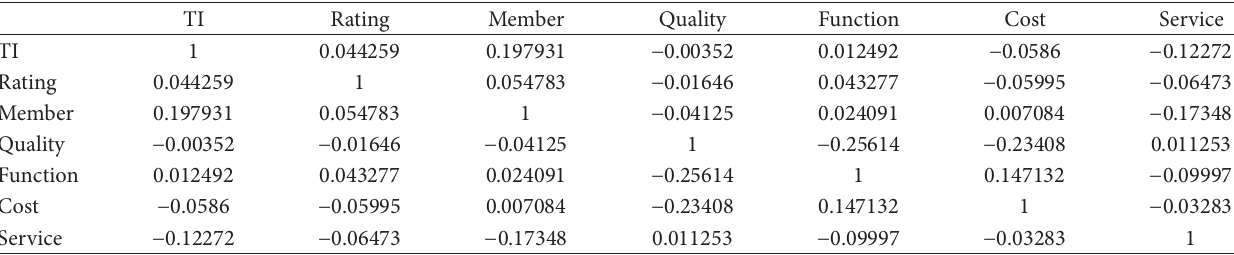
Table 7: Correlation analysis (𝑝 < 0.05 ).